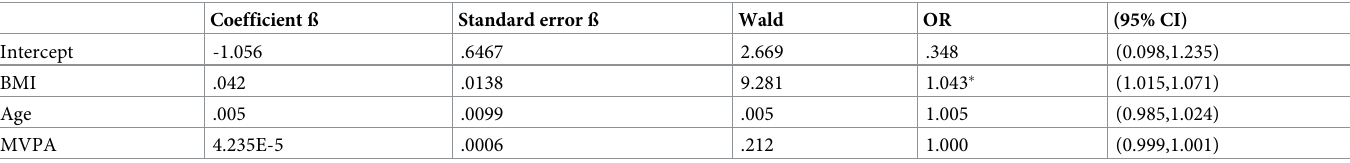
Table 5. Poisson regression model, relationship between total area of MSD with BMI, age and